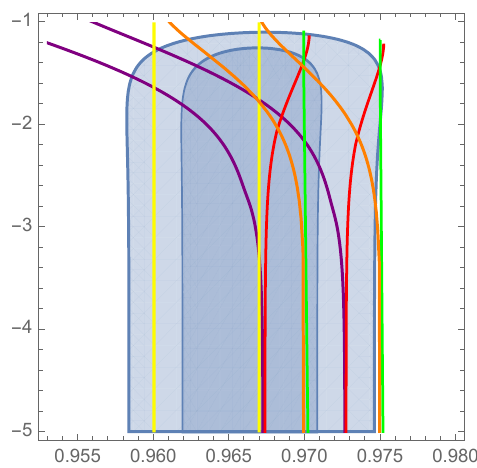
Figure 4 . Predictions of (cid:11) -attractors and KKLTI/BI models. The dark (light) blue area is the Planck 2018 1 (cid:27) (2 (cid:27) ) region, with an account taken of TT, TE, EE + lowE + lensing + BK14+BAO [1]. Two yellow lines on the left panel are for the quadratic T-model of (cid:11) -attractors at N e = 50 and N e = 60. Two purple lines are for the quartic KKLTI model, two red lines are for the quartic BI model. As one can see, the combination of the simplest (cid:11) -attractor model and the quartic KKLTI/BI model (including the models interpolating between KKLTI and BI) completely cover the 1 (cid:27) area of the Planck 2018 data. Two orange lines show the predictions of the quadratic KKLTI model, and two green lines are for the quadratic BI